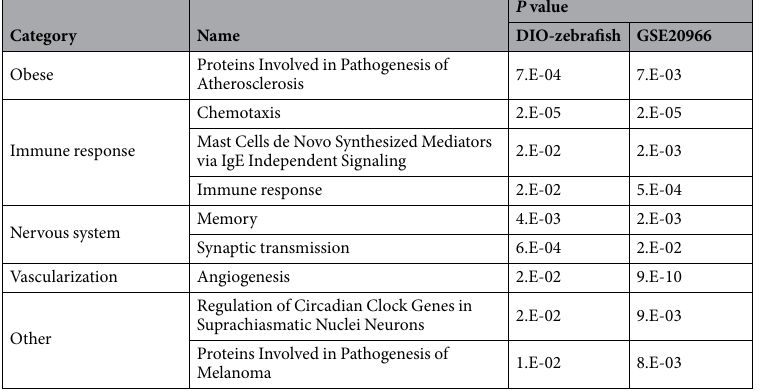
Table 2. Gene-sets common to the hepatopancreas of DIO zebrafish and pancreatic beta cells of human type 2 diabetes patients (GSE20966) according to Gene-Set Enrichment Analysis (GSEA) analysis.